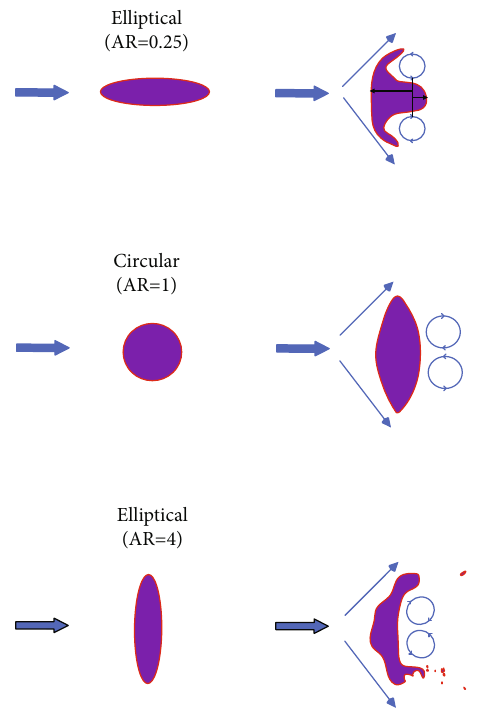
Figure 7: Breakup of elliptical liquid jets of three aspect ratios.